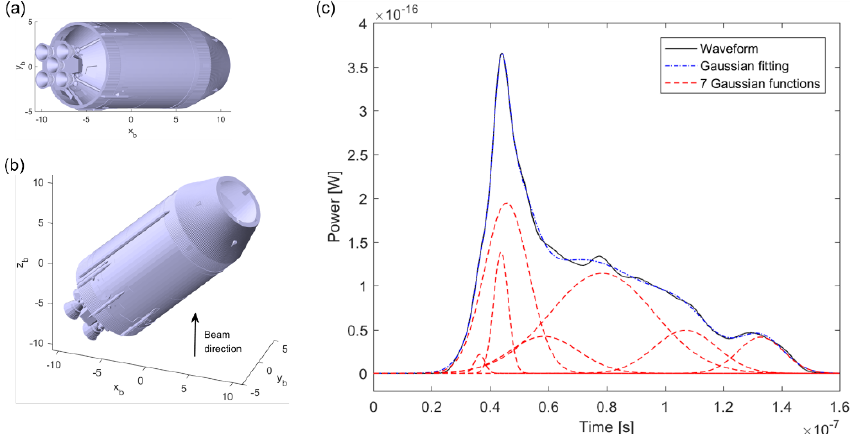
Figure 11. The ( a ) reflected surface, ( b ) orientation of rocket body, and ( c ) the echo waveform and 7 Figure 11. The( a )reflectedsurface, ( b )orientationofrocketbody, and( c )theechowaveformand7Gaussian Gaussian functions obtained from the Gaussian decomposition for -45° rotation about the y-axis w.r.t. functions obtained from the Gaussian decomposition for − 45 ◦ rotation about the y-axis w.r.t. Figure Figure 2b.